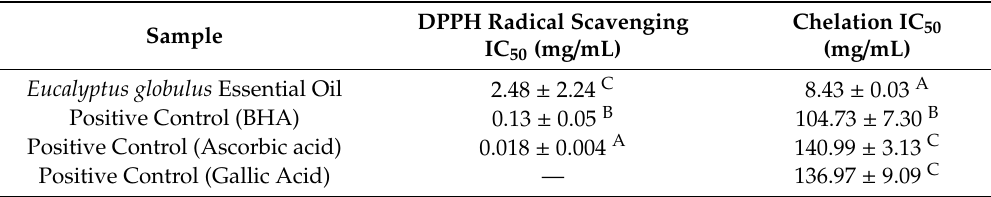
Table 2. Antioxidant property of Eucalyptus globulus volatile oil in vitro